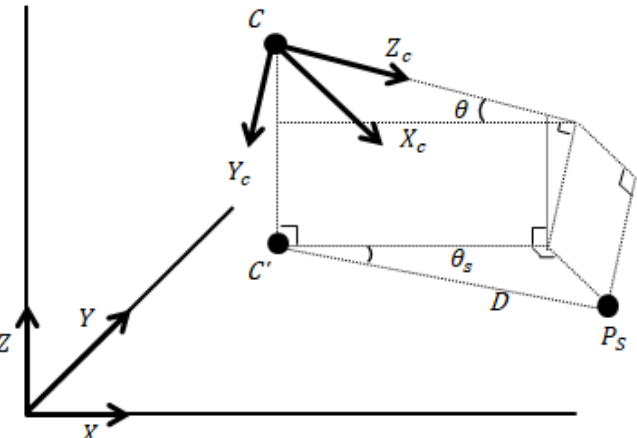
Figure 5. Stereo vision distance perception.